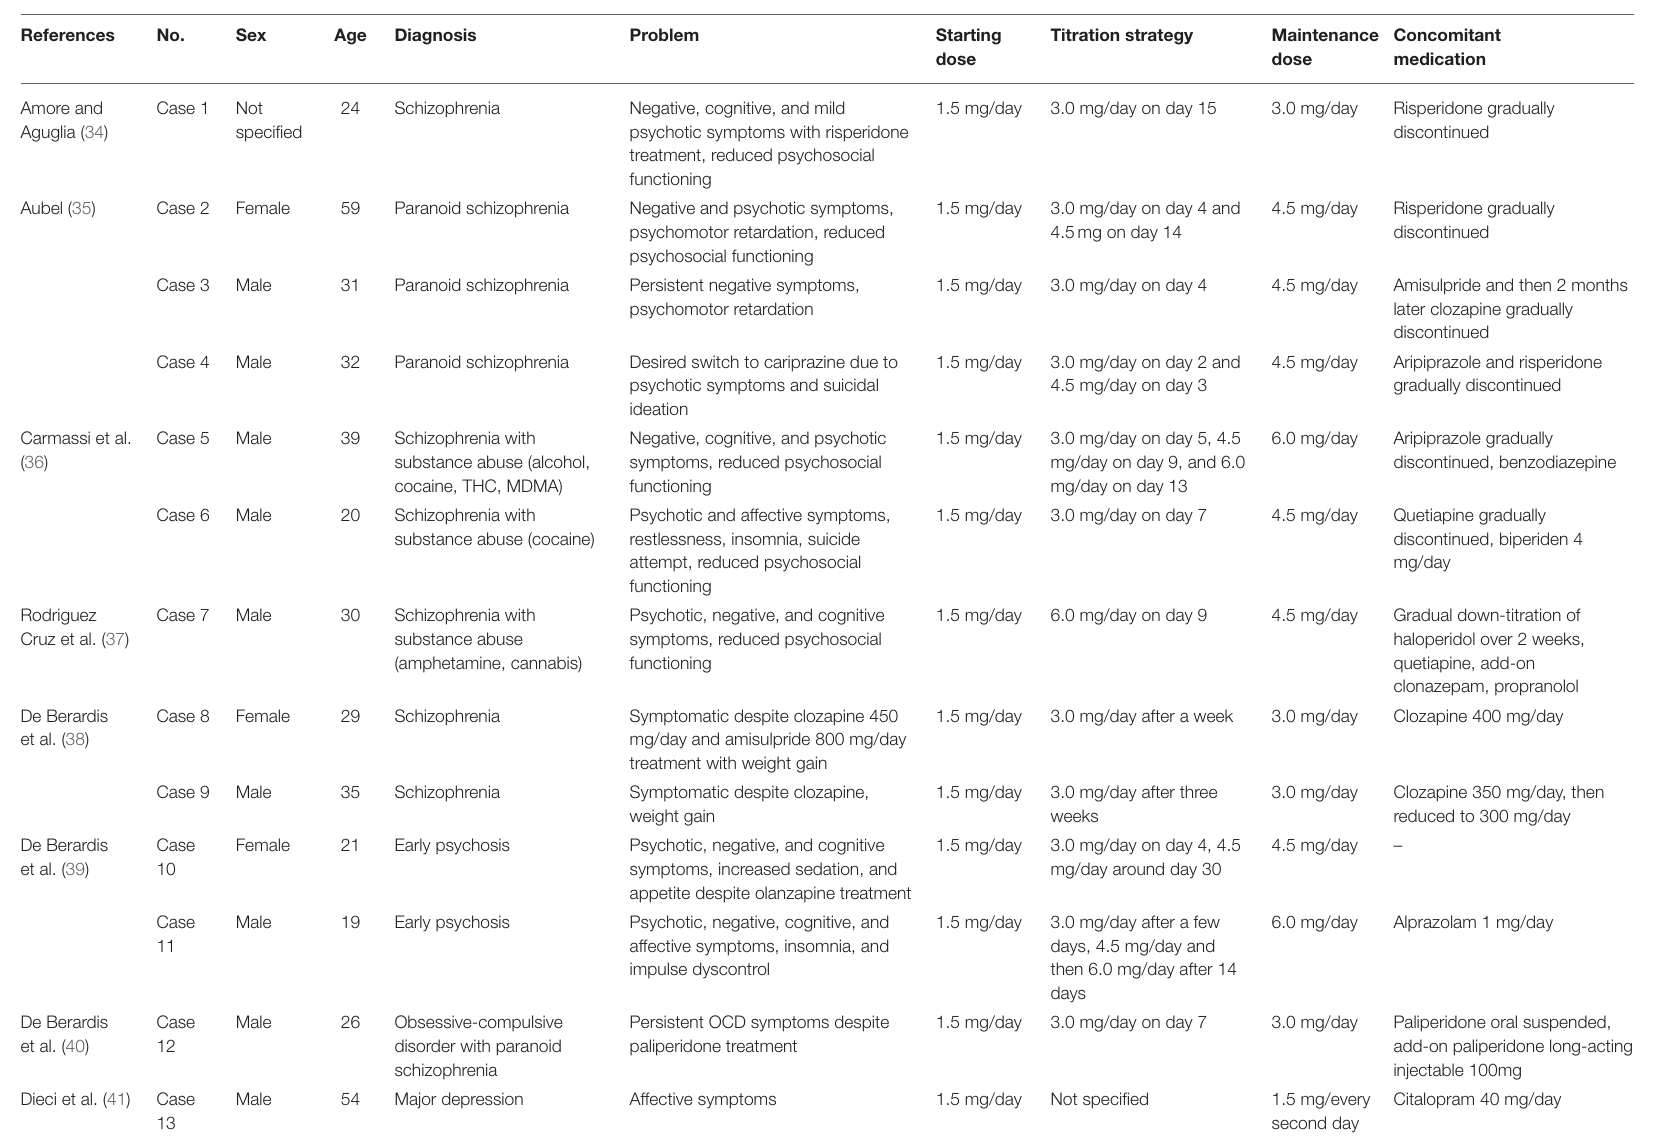
TABLE 2 | Summary of